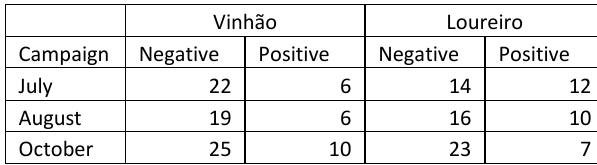
Table 1. Number of FD positive and FD negative leaves in